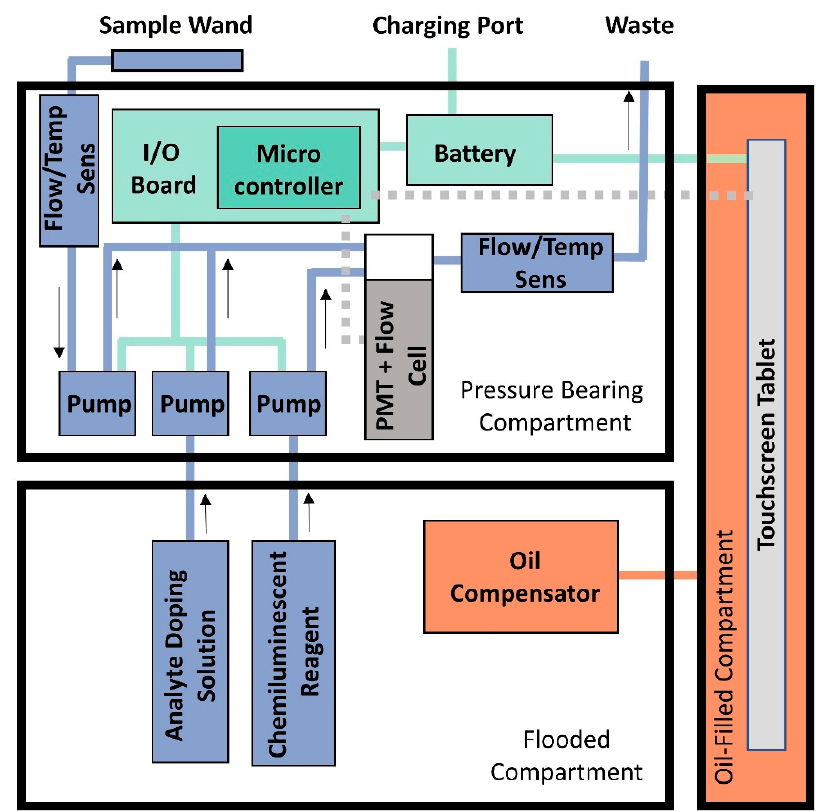
Figure 2. Block diagram of DISCO II showing the layout of DISCO and highlighting the function of the key features. The different operating systems are color coded, showing distinction between the fluidics system (blue), electronics system (green), the oil-compensated section (orange), and the tablet and PMT (gray). The other two compartments (pressure-bearing and flooded) are labeled accordingly. The blue arrows associated with the fluidics system indicate the direction of flow.